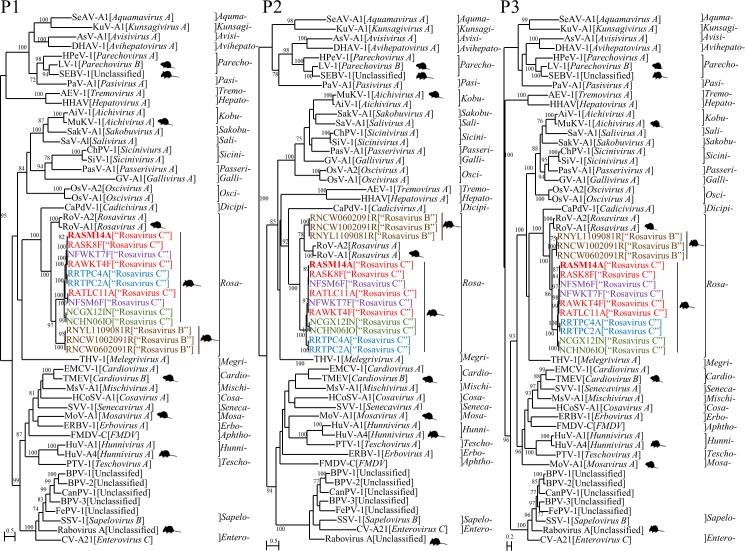
Phylogenetic analysis of the amino acid sequences of P1, P2 (excluding 2A) and P3 (excluding 3A) of the novel rodent picornavirus species with genomes completely sequenced.The strains identified in this study are shown in colors representing different host species of street rodents, Norway rats (strain number RNXXX) (brown), and wild rodents, Coxing's white-bellied rats (NCXXX) (green), roof rats (RRXXX) (blue), chestnut spiny rats (NFXXX) (purple) and Indochinese forest rats (RAXXX) (red) respectively. The strain RASM14A that was successfully isolated in 3T3 cells is shown in bold. The present and other known rodent picornaviruses are indicated by a pictorgram of rodent. The trees were constructed by maximum-likelihood method with bootstrap values calculated from 100 trees and only those >70% are shown. The scale bar indicates the estimated number of substitutions per 2 or 5 amino acids. BPV-1, bat picornavirus 1 (HQ595340); BPV-2, bat picornavirus 2 (HQ595342); BPV-3, bat picornavirus 3 (HQ595344); CanPV-1, canine picornavirus (JN831356); FePV-1, feline picornavirus (JN572117); FMDV-C, foot-and-mouth disease virus—type C (NC_002554); MuKV-1, murine kobuvirus 1 (JF755427).